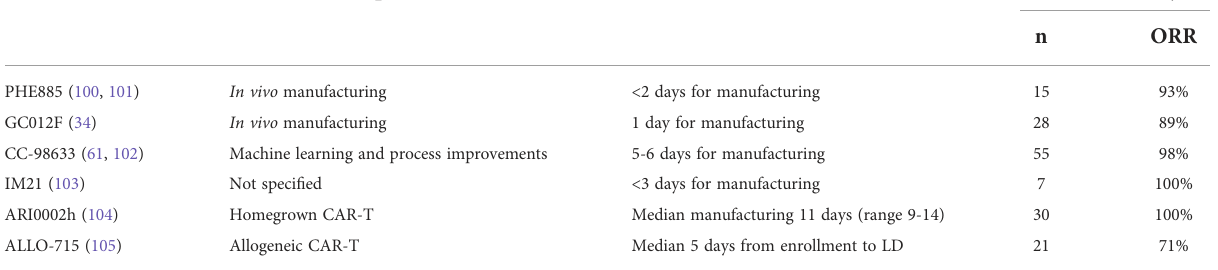
TABLE 3 Selected studies of BCMA CAR-T therapies with lower brain-to-vein times. CAR-T Product Mechanism of quicker turnaround Brain-to-vein times*